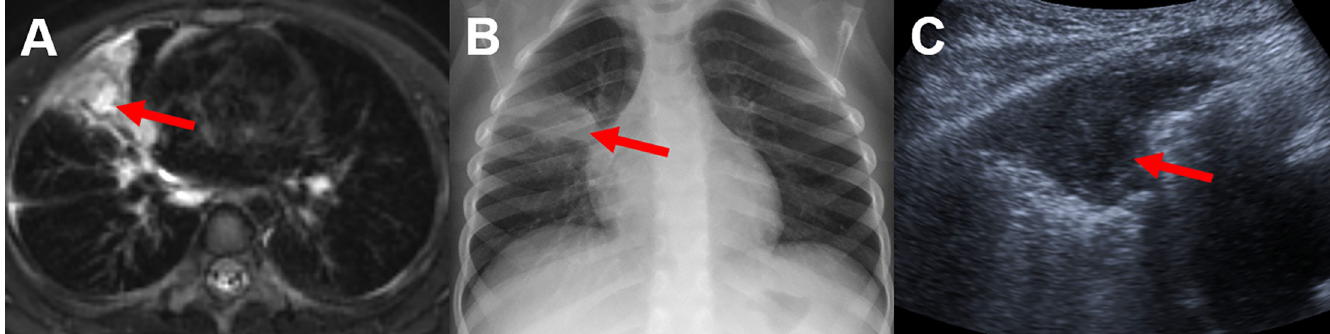
Fig 2. Contrast-enhanced MRI, CXR and LUS study of a 3-year old child. T2 weighted MRI (A) demonstrates an abscess formation within the consolidation in the middle lobe (red arrow), not detected by CXR (B) showing only consolidation (red arrow). In LUS (C) the abscess demarcates barley and was not diagnosed initially (red